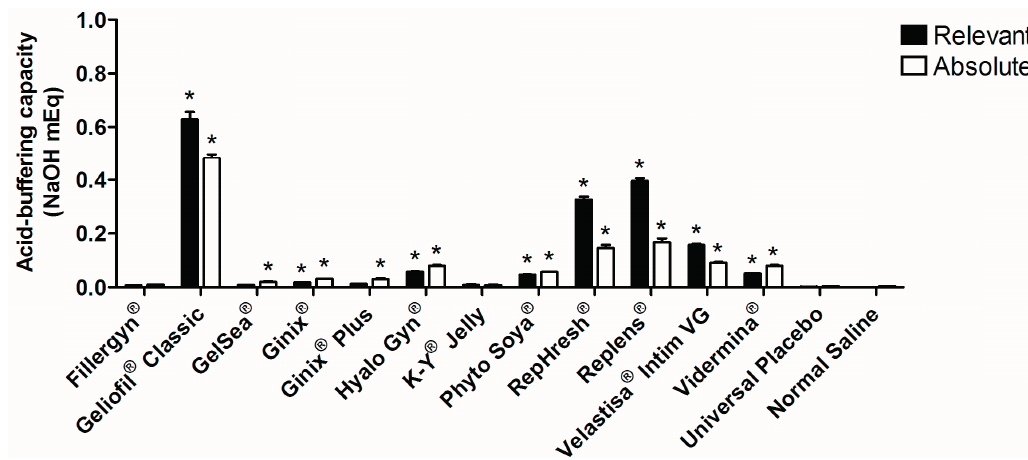
Figure 1. The relevant and absolute buffering capacity of tested products in normal saline. Individual columns and vertical bars represent mean and SD values, respectively ( n = 3). ( * ) Denotes a significant difference ( p ˂ 0.05) when comparing to the values of the relevant or absolute buffering capacity for plain normal saline.